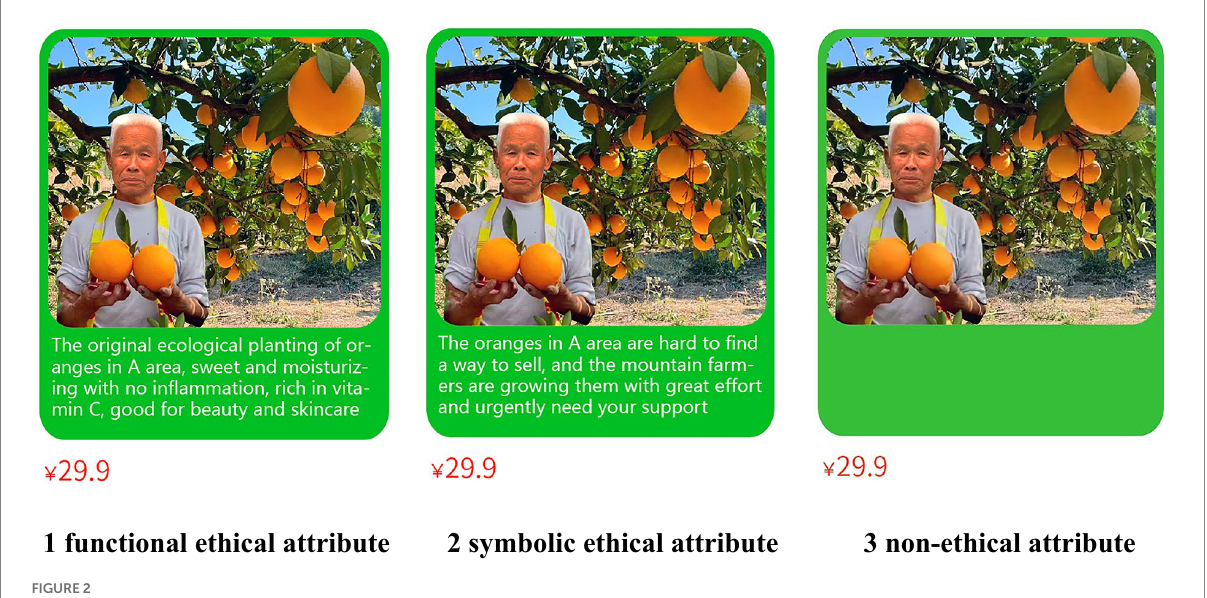
FIGURE 2 Image of ethical attributes of farmer-assisting agricultural products in Study 1.